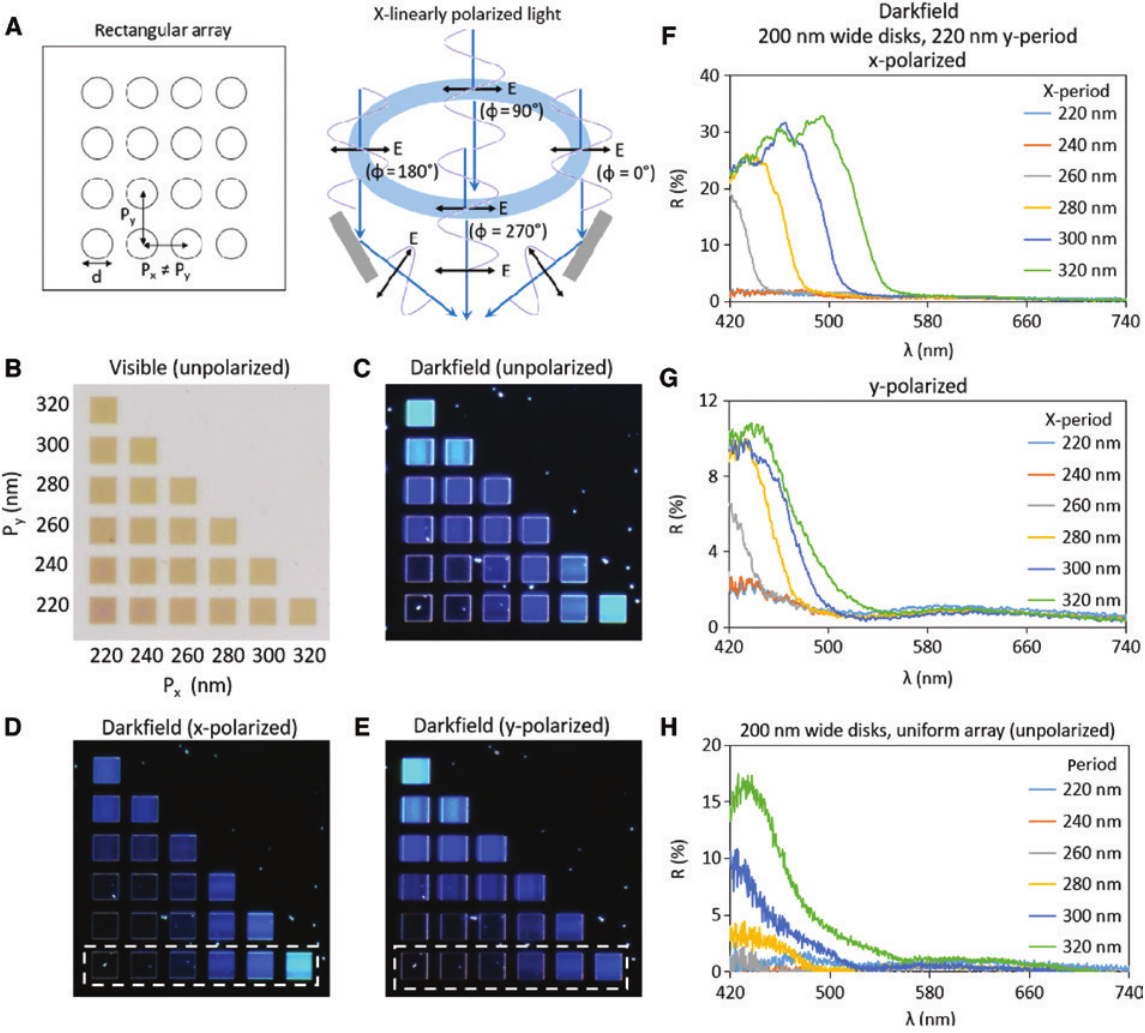
Figure 2: Polarization-dependent colors from rectangular arrays of single Al disks. (A) Structure of rectangular disk array, where the x -period P light are shown. (B) Unpolarized brightfield, (C) unpolarized, (D) x -polarized, and (E) y -polarized darkfield images of rectangular